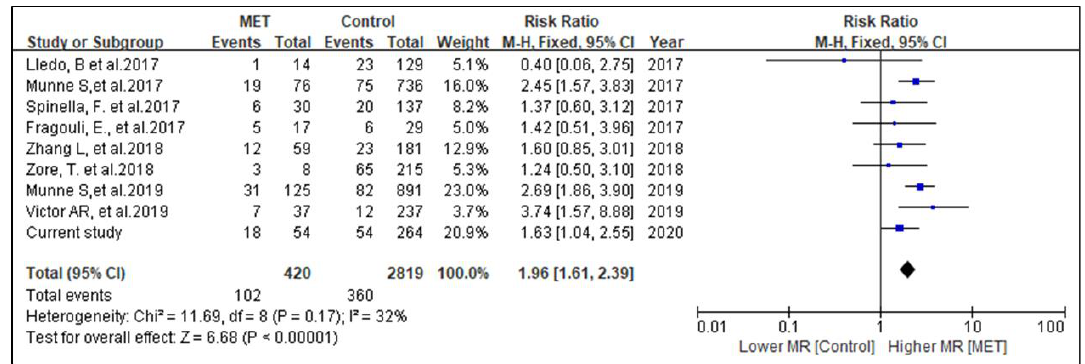
Figure 4. Meta-analysis of the comparison of miscarriages.